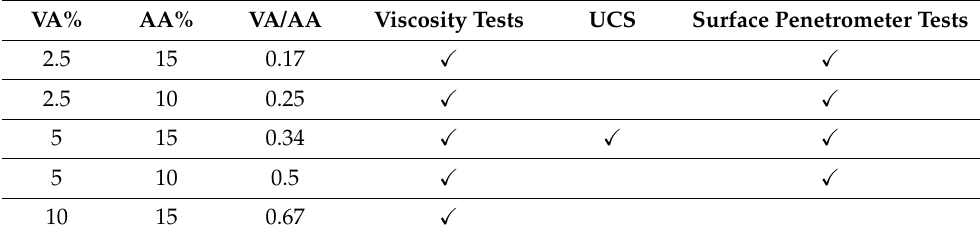
Table 3. Tests performed on each of the geopolymer mix